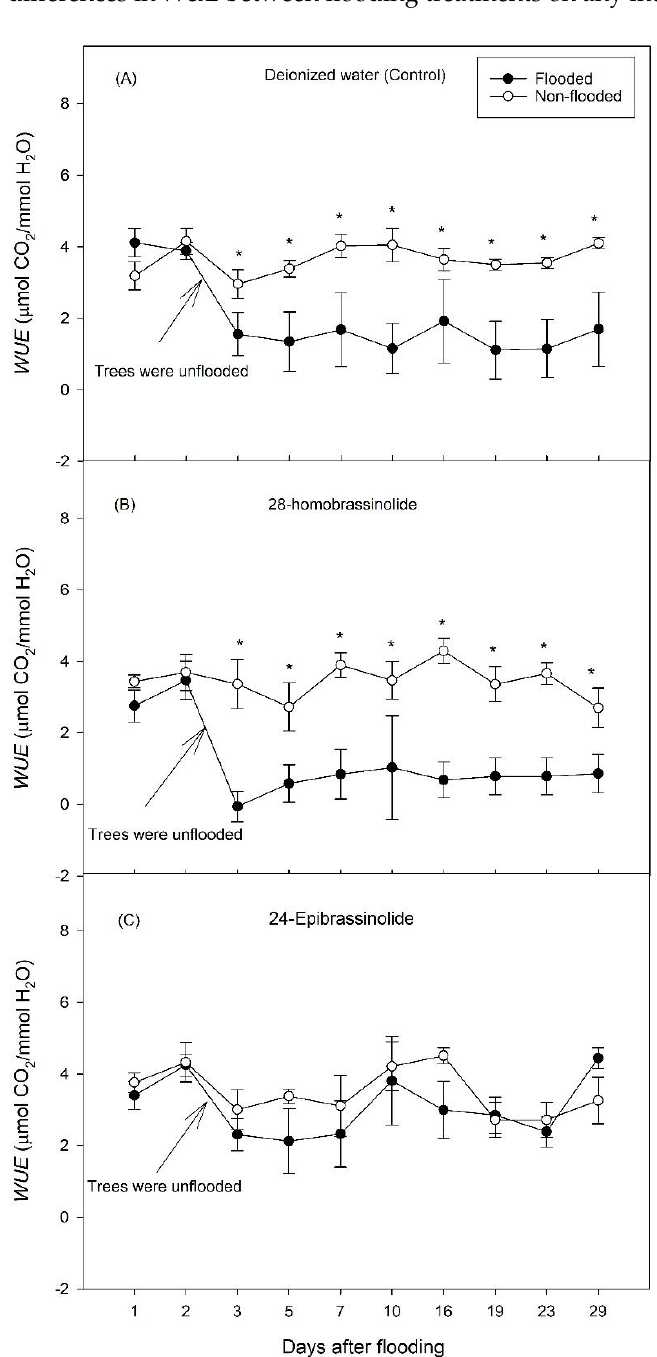
Figure 4. Effect of flooding on water use efficiency ( WUE ) of ‘Monroe’ avocado trees treated with ( A ) deionized water as a control, ( B ) 28-homobrassinolide, or ( C ) 24-epibrassinolide, (Experiment 1). Symbols and bars indicate means ± std. err. Significant differences ( p ≤ 0.05) between flooding treatments are indicated with an asterisk and were determined by repeated-measures ANOVA. ‘Trees were unflooded’ indicates the day on which trees were removed from the flooding treatment to start the recovery period.